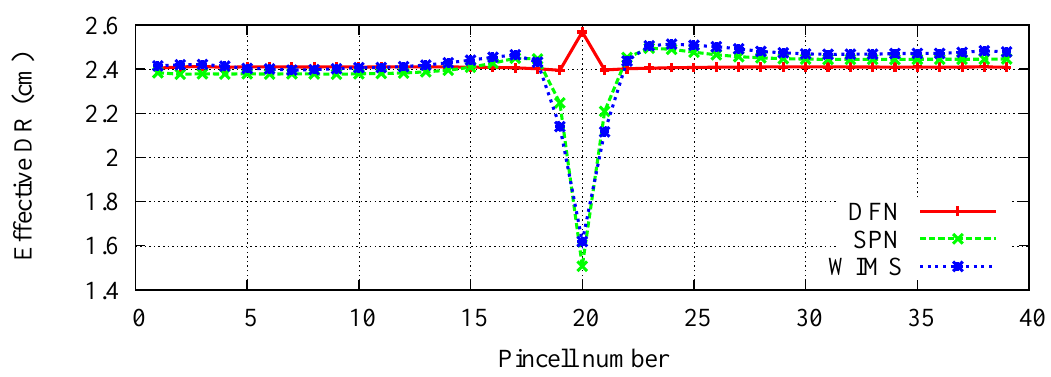
Figure 2: Effective group 1 radial diffusion coefficient for PANTHER pin-by-pin diffusion (DFN), SPN-corrected and WIMS-CACTUS solutions.